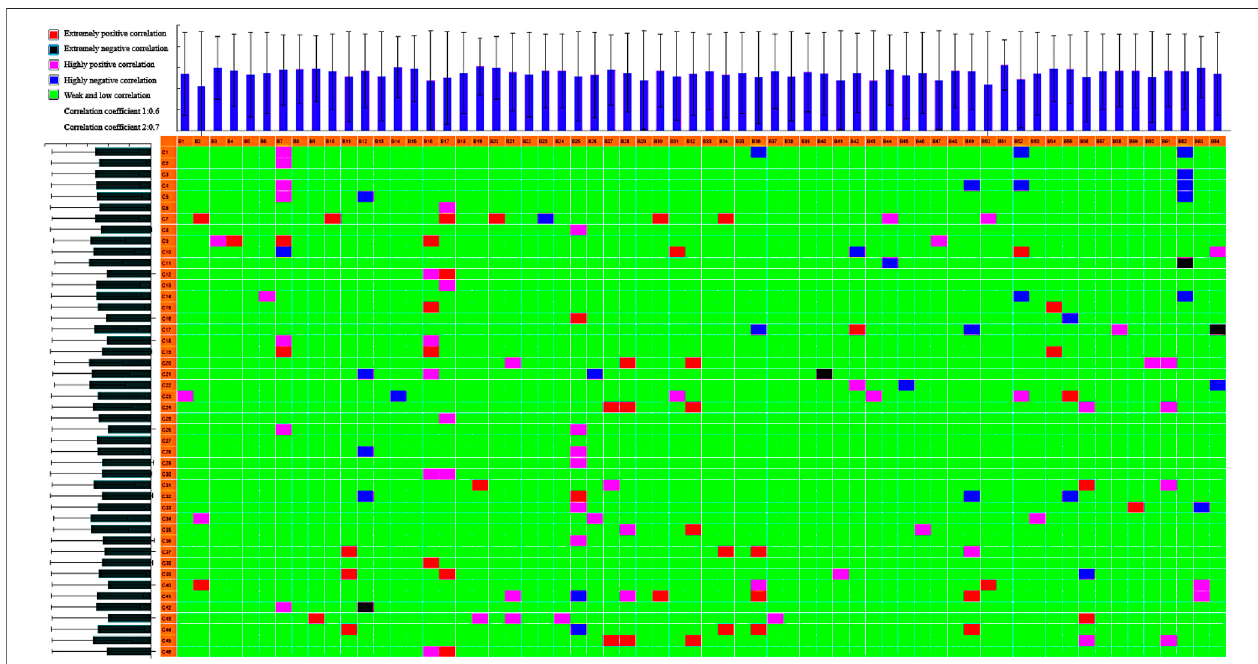
FIGURE 8 | Heatmap of correlations between biomarkers and serum constituents in KLX. B1 – B64 show the biomarker (listed in Supplementary Table S1 ); C1 – C45showtheserumcomponent(listedin SupplementaryTableS5 ).R1,0.6;R2,0.7.Extremelypositivecorrelation;extremelynegativecorrelation;highlypositive correlation; highly negative correlation; weak/low correlation. KLX,